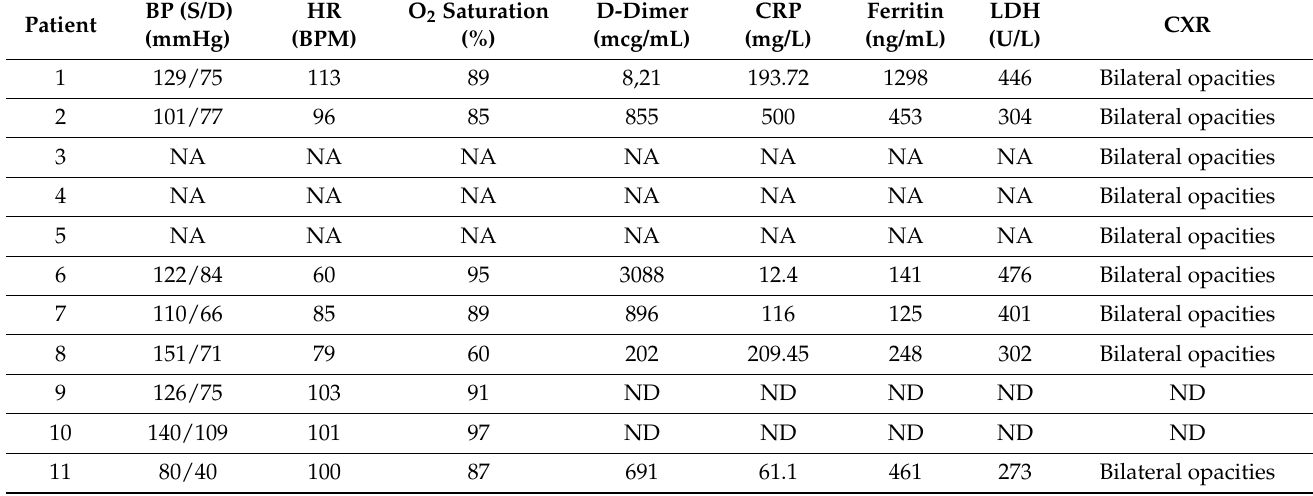
Table 4. Severity of COVID-19 on presentation to the Emergency Room.